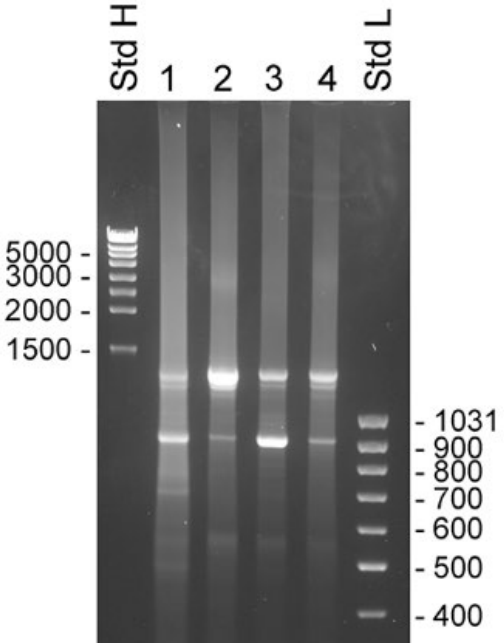
Figure 4. Transcripts detected by 3′ RACE in unfractionated BPH and compartments of LNCaP cells. RACE products were analyzed by electrophoresis in 1% agarose gels. Experiments were done with the primer KLK4Ne3f, which is specific for KLK4, exon 4, which will generate product from both classical and truncated KLK4, and KLK4T2. The 3′ RACE-ready cDNA was synthesized with unfractionated RNA from human BPH tissue (lane 1) and LNCaP cells (lane 2), and RNA from LNCaP cytosol (lane 3) and nucleus (lane 4). MassRuler high (Std H) and MassRuler low (Std L) were used as size markers. Relevant sizes in bp are indicated in the figure.